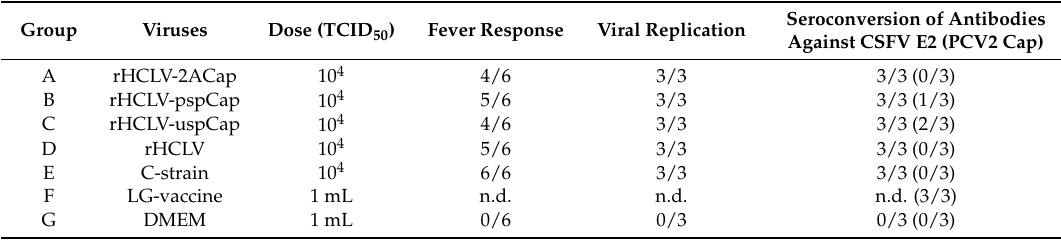
Table 3. Fever response, viral replication, and seroconversion of the rabbits inoculated with the recombinant viruses.